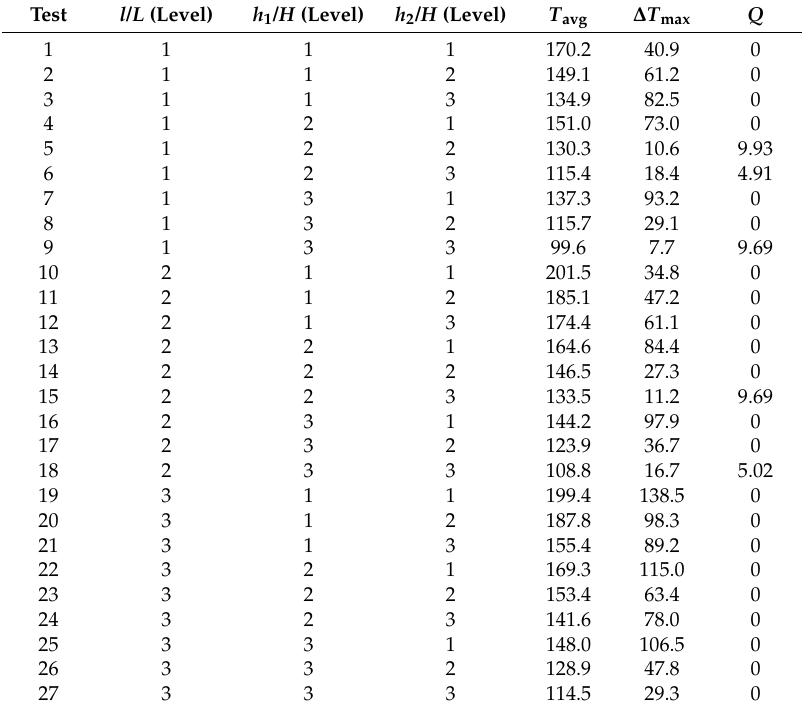
Table 2. Average temperature T avg ( ◦ C), maximum temperature difference ∆ T max ( ◦ C), and fitness function Q in all tests. Each test used an oven configuration specified with levels in the same